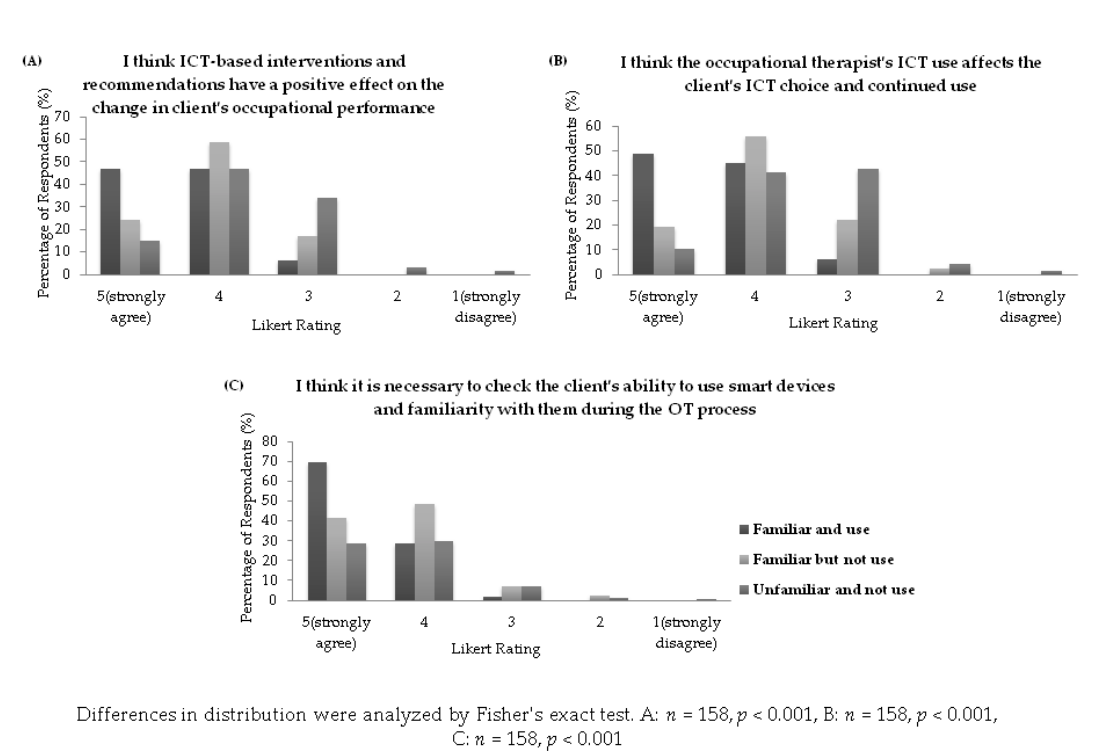
Figure 1. Distribution of opinion according to ICT use.